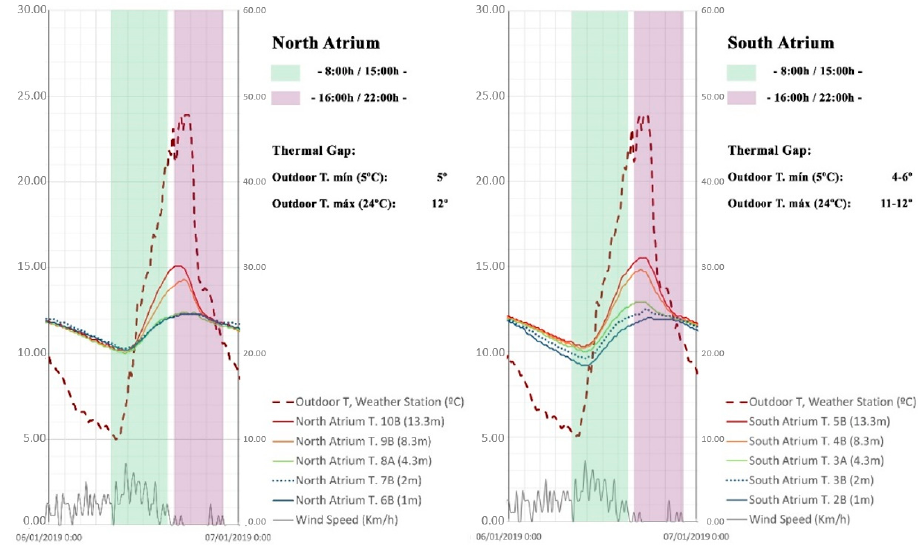
Figure 3. Comparative behavioral thermodynamic between the atriums. Note that the timetable of the morning and evening occupations of the building is indicated in green and purple respectively.